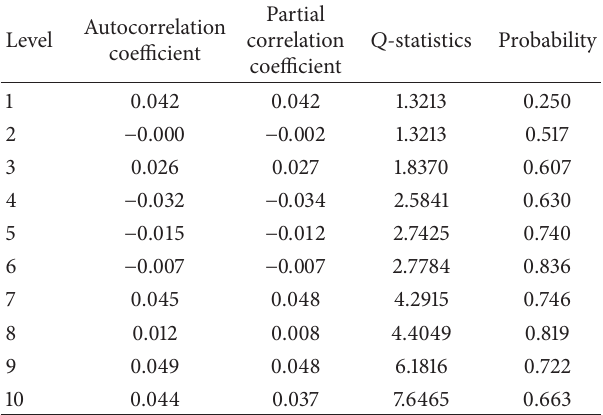
Table 1: 𝑅 𝑚,𝑡 ’s autocorrelation coefficients and partial correlation